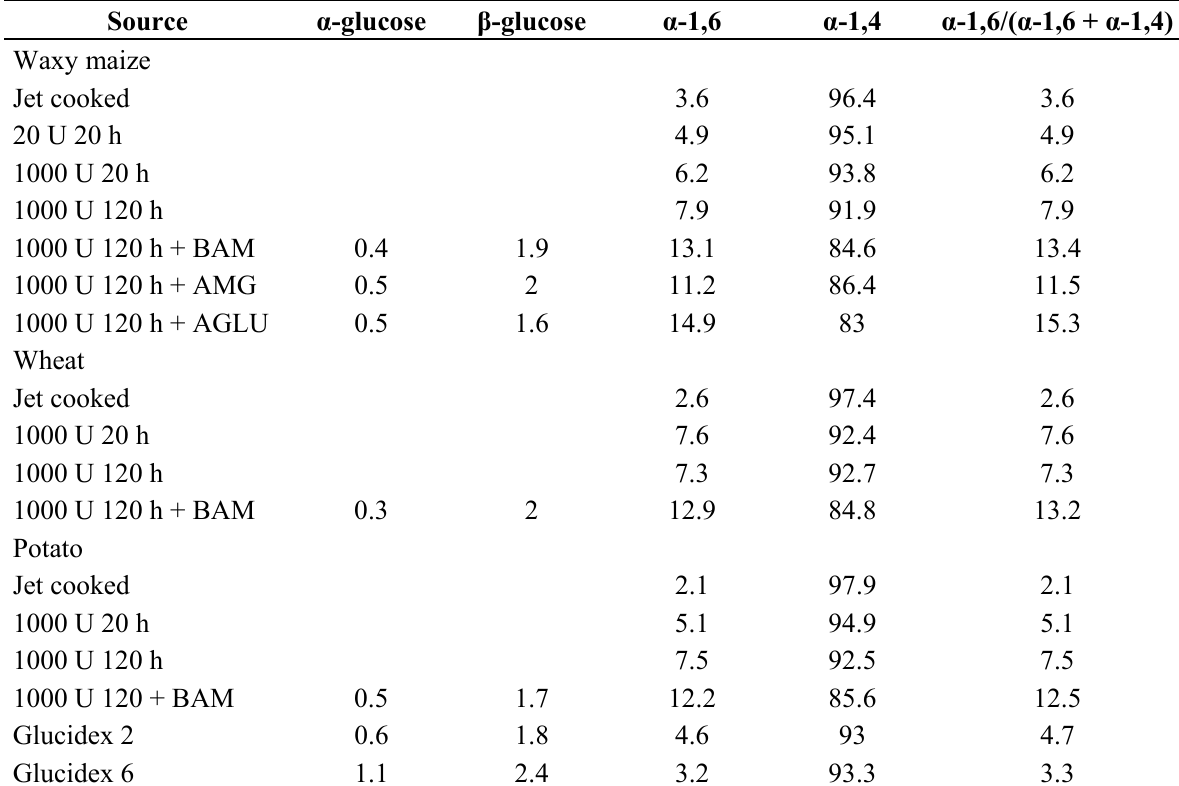
Table 1. Relative content (%) (±0.3%) of α -glucose, β -glucose monomers (or end-groups) and α -1,6 and α -1,4 branching in wheat, potato and waxy maize jet cooked and enzymatic modified